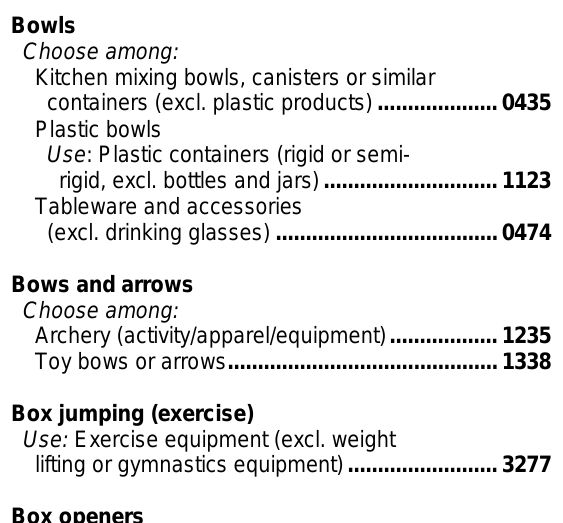
Also consider: Knives Box springs Choose among: Baby mattresses or pads (excl. Mattresses, nonbaby (excl. If type of box spring is not specifically identified, Boxes Choose among: Jewelry boxes/jewelry chests Use: Other containers (excl. vacuum Metal containers (excl. aerosols, Plastic containers (rigid or semi-